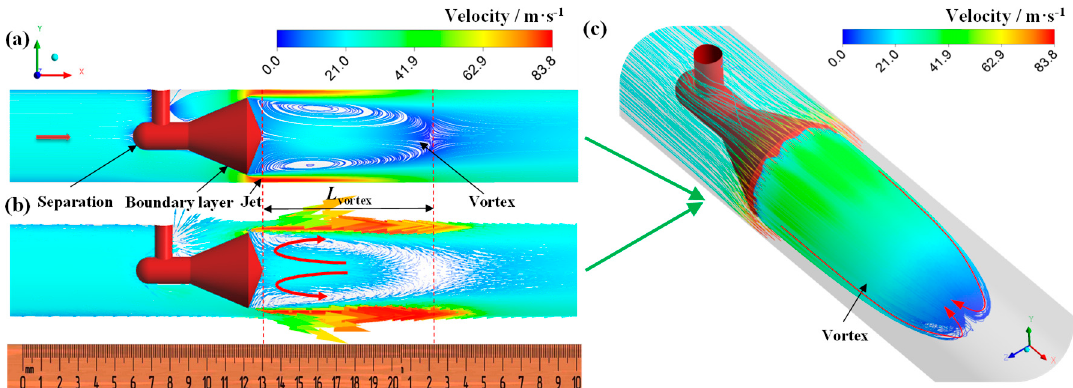
Figure 8. Streamline and velocity vector distribution under single-phase gas flow ( P = 0.2 MPa, U sg =